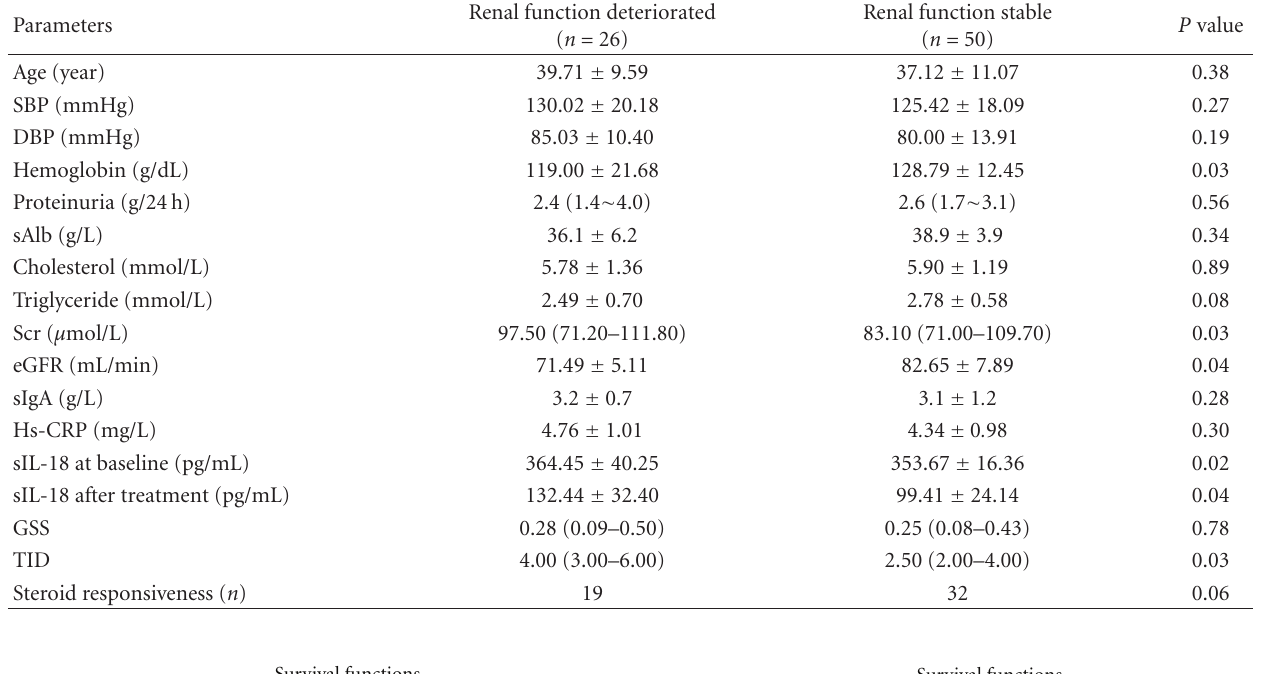
Table 5: Comparison of clinical and histological parameters between IgAN patients with renal function deterioration or not in follow-up. Parameters